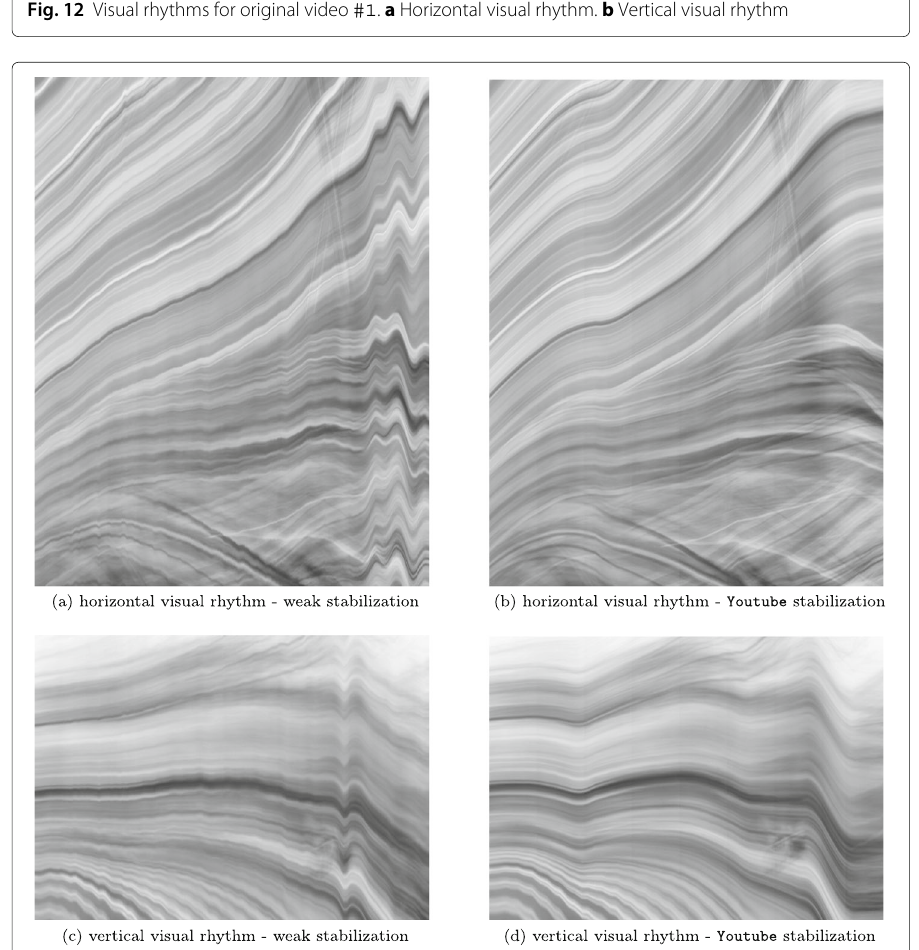
Fig. 13 Visual rhythms for stabilized video #1 . a Horizontal visual rhythms for weak stabilization. b Horizontal visual rhythms for YouTube stabilization. c Vertical visual rhythms for weak stabilization. d Vertical visual rhythms for YouTube